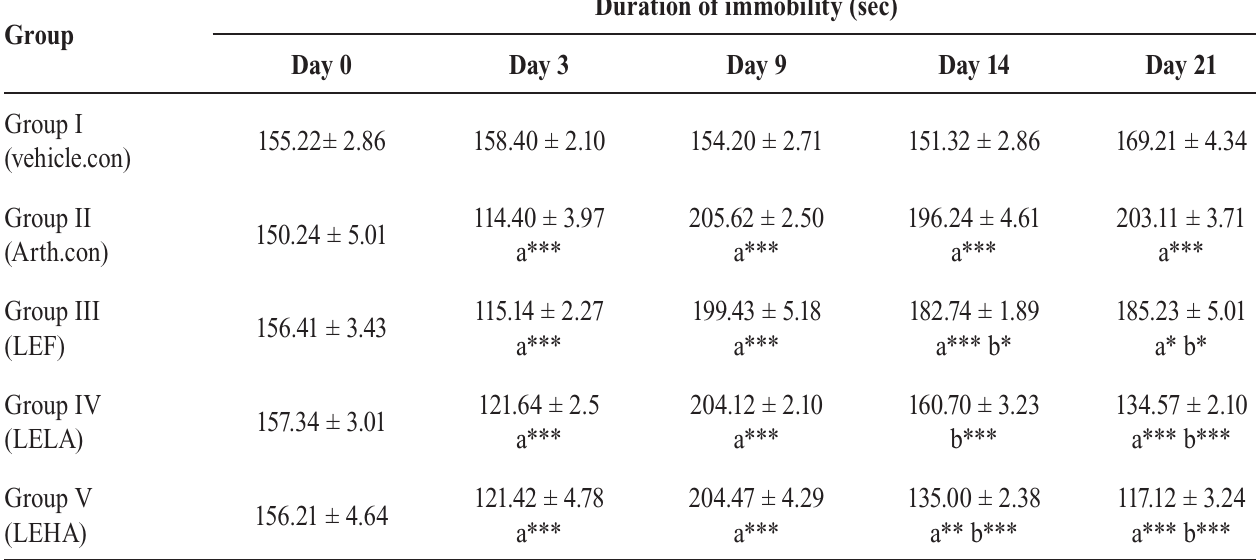
TABLE VIII- Effect of leflunomide and amitriptyline on the duration of immobility in the forced swimming